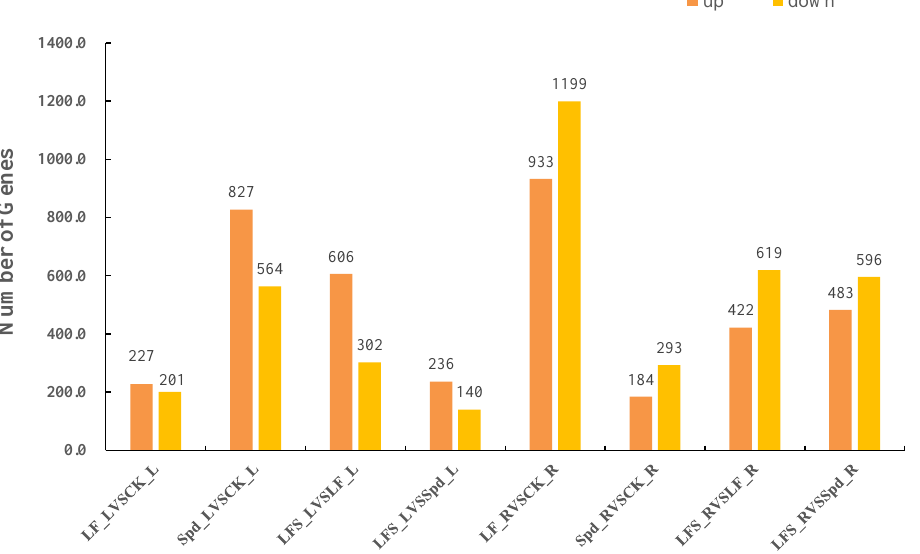
Figure 2. Number of significantly differentially expressed genes in different treatments. LF_L